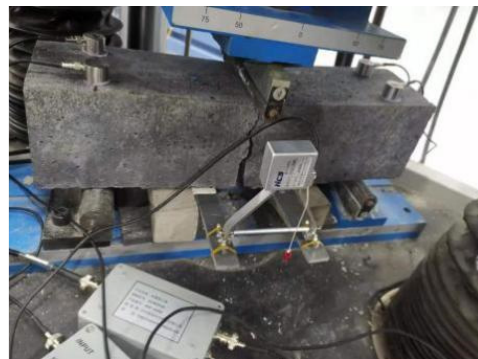
Figure 4. TPB test with AE.